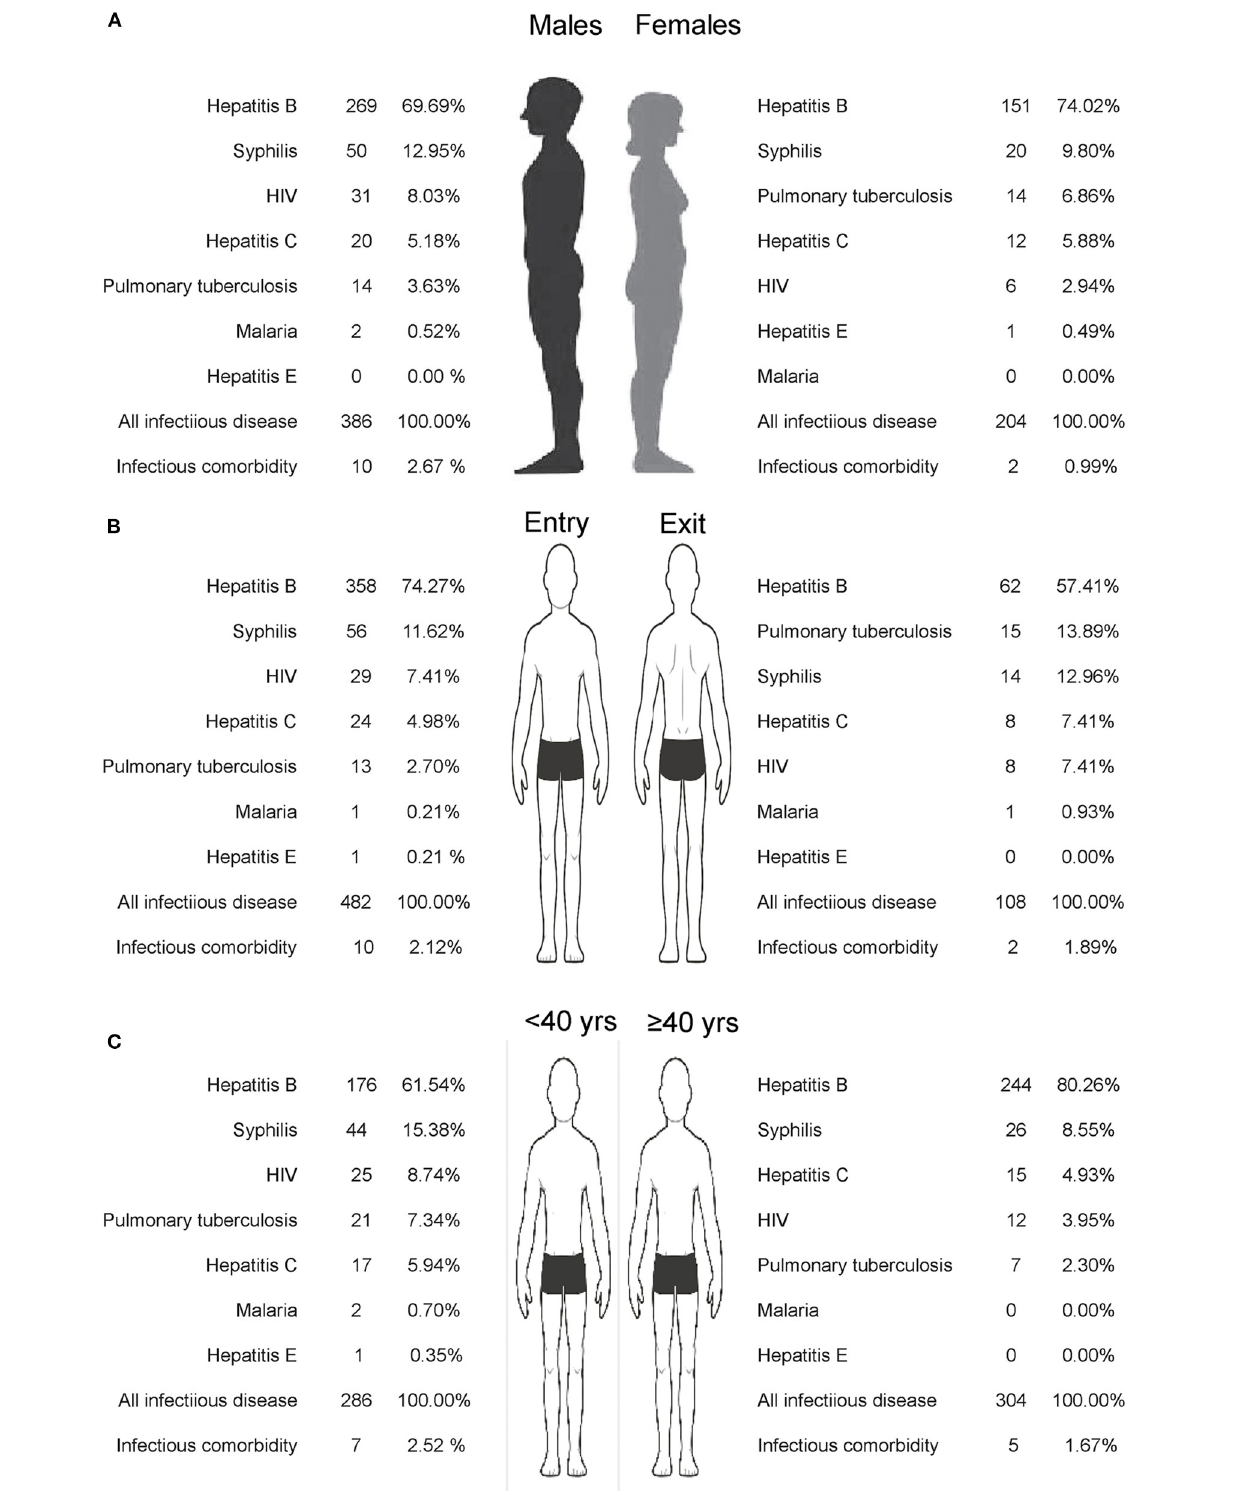
Frontiers in Public Health |